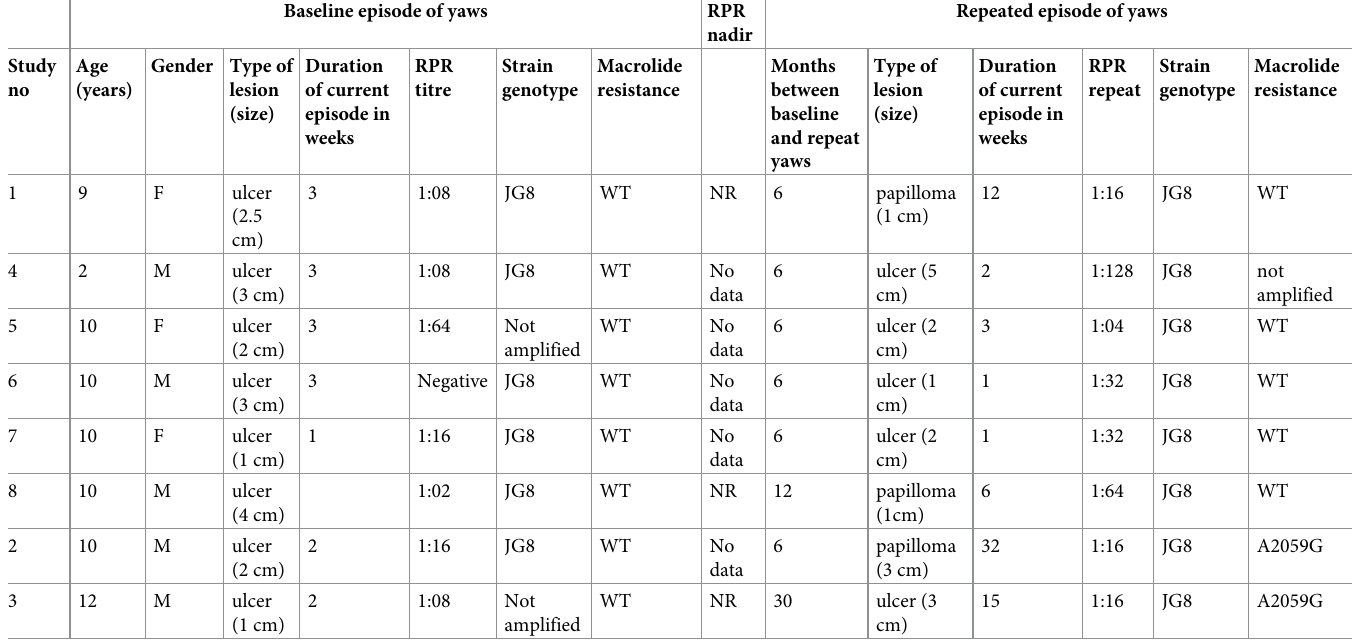
Table 4. Clinical and laboratory findings of 8 cases of PCR-confirmed yaws reinfection among individuals identified during a public health intervention for yaws eradication (active case detection analysis). Baseline episode of yaws RPR